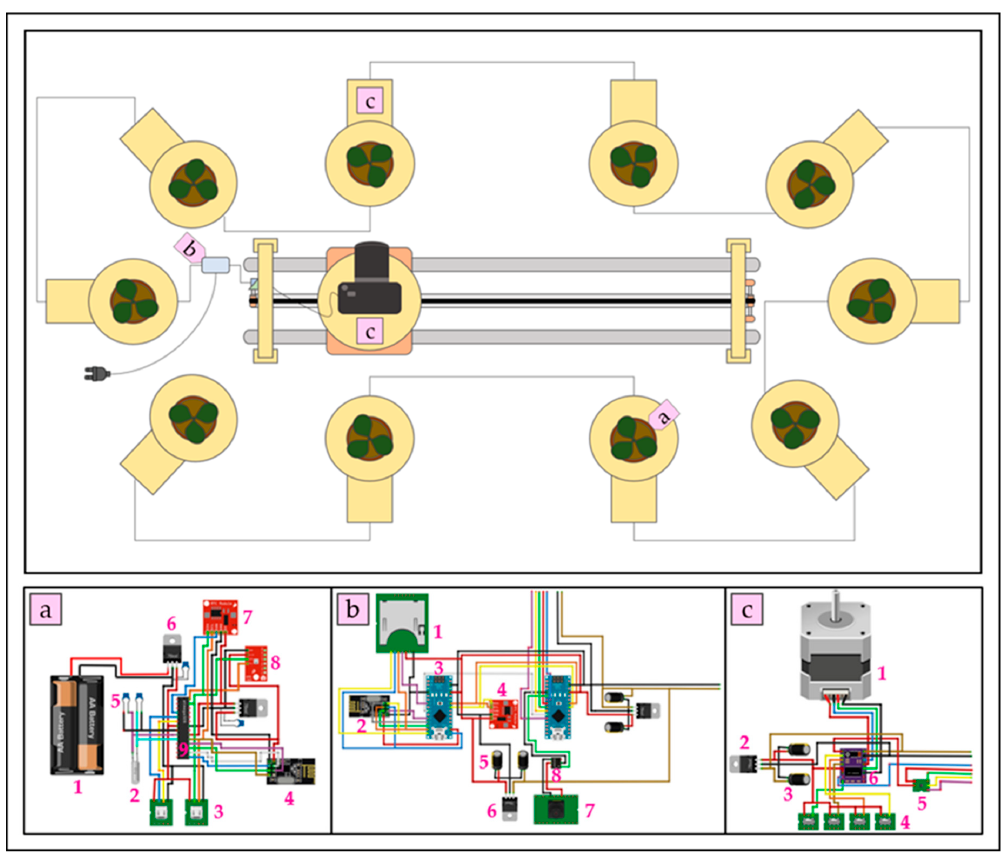
Figure 1. Schematic representation of the low-cost and automatic phenotyping platform. The platform consists of the following electronical components: ( a ) data acquisition module with (a1) 2